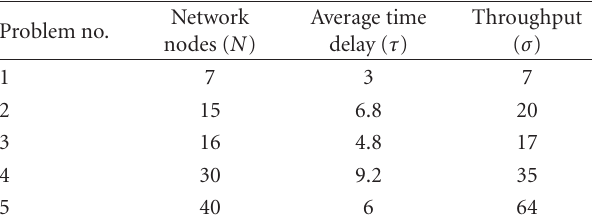
Table 6: Performance